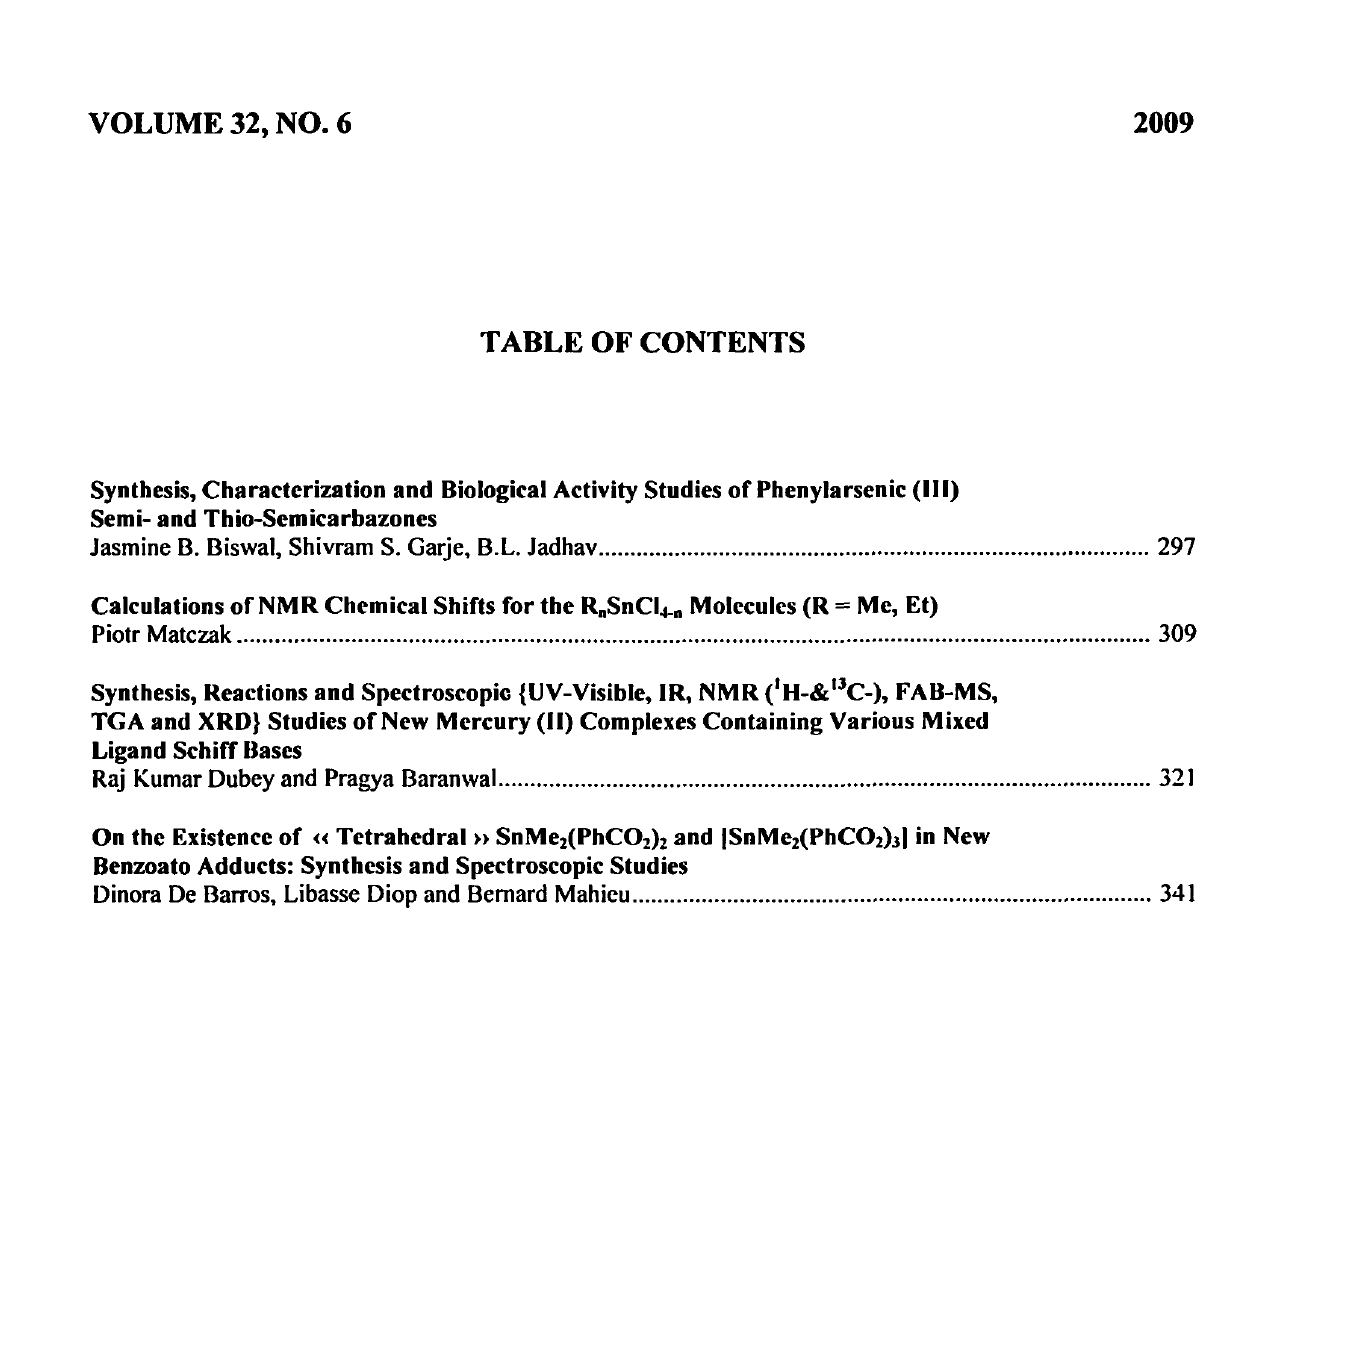
Synthesis, Characterization and Biological Activity Studies of Phenylarsenic (III) Semi- and